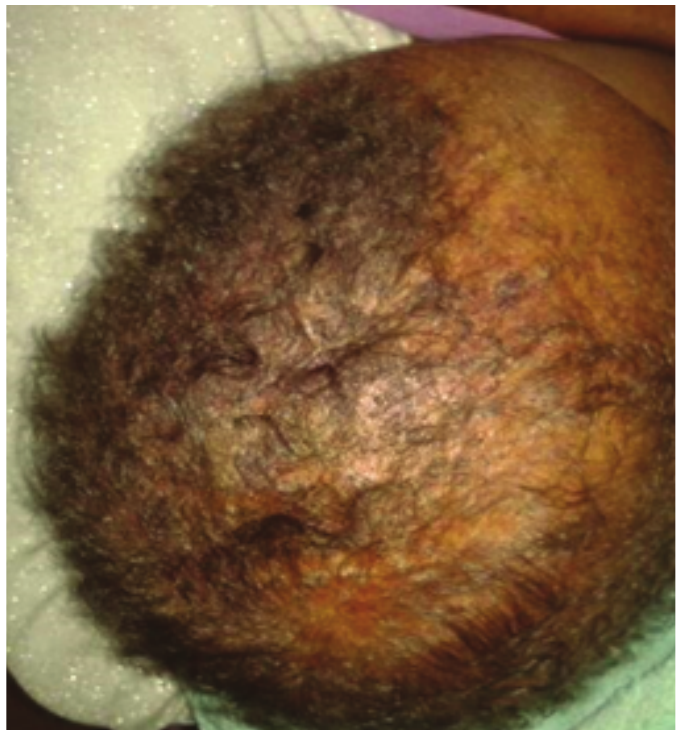
Figure 6: Scales and cru station of the